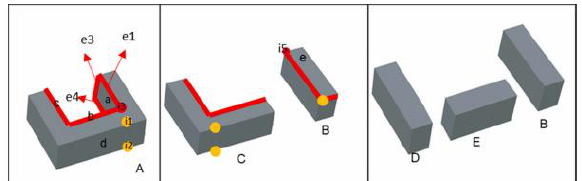
Figure 1. Topological-based approach of subdivision process of 3DVP at a face (Jaljolie et al.,